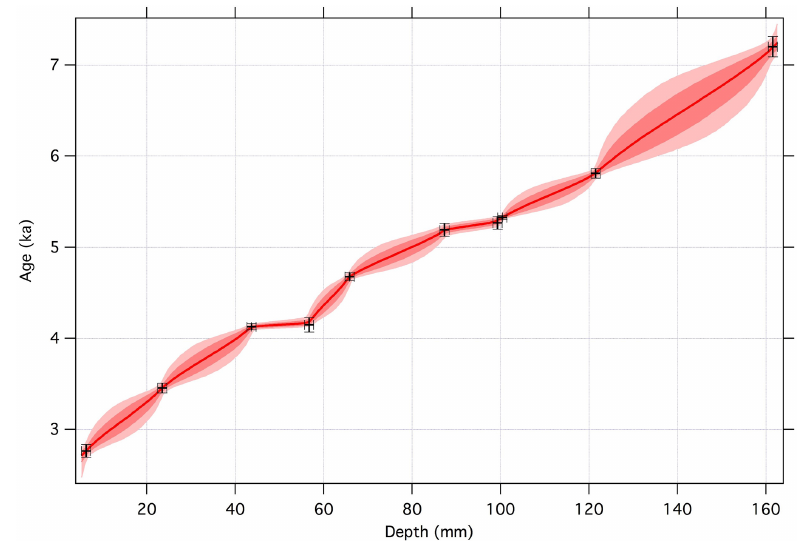
Figure 3. CC27 depth–age model. The outer shaded zones define the 95% uncertainties.